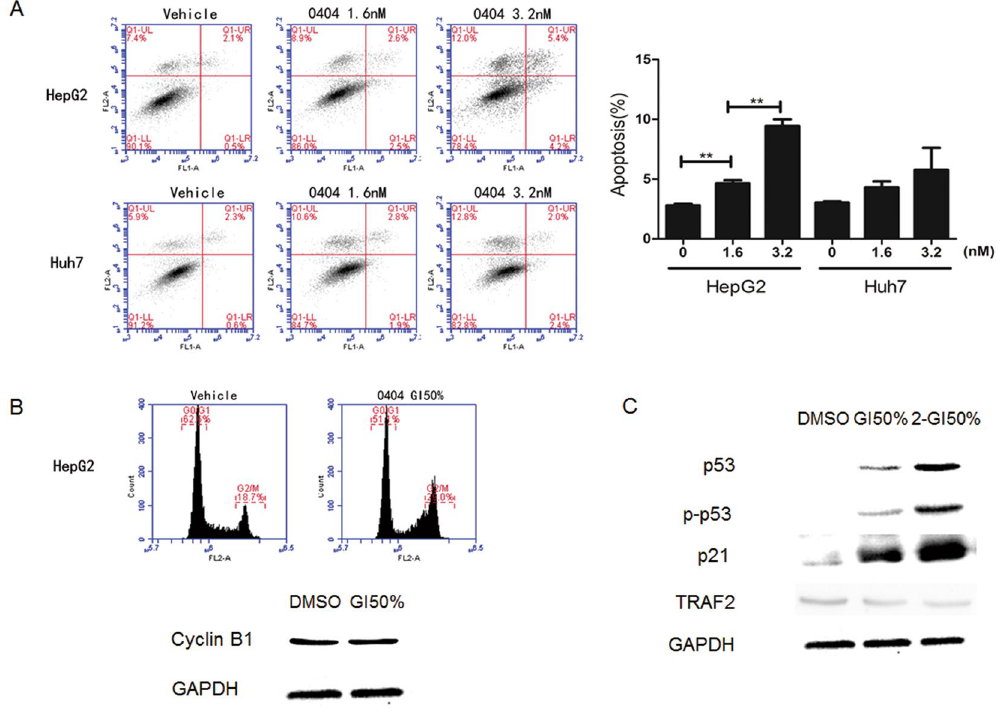
Figure 2. Anti-cancer effects of 0404. ( A ) 0404 inducing apoptosis of HepG2 cells was highly depending on the concentration. ( B ) The majority of HepG2 cells were arrested at the G2/M phase at GI50% concentration and cyclinB1 was decreased at the same time. ( C ) 0404 induced up-regulation of p53, the phosphorylated p53 protein, the p53 targets such as p21 and down-regulation of TRAF2 protein in HepG2